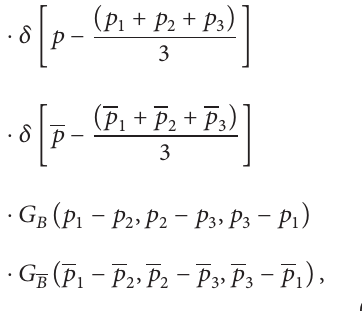
Similarity, the distribution of baryon and